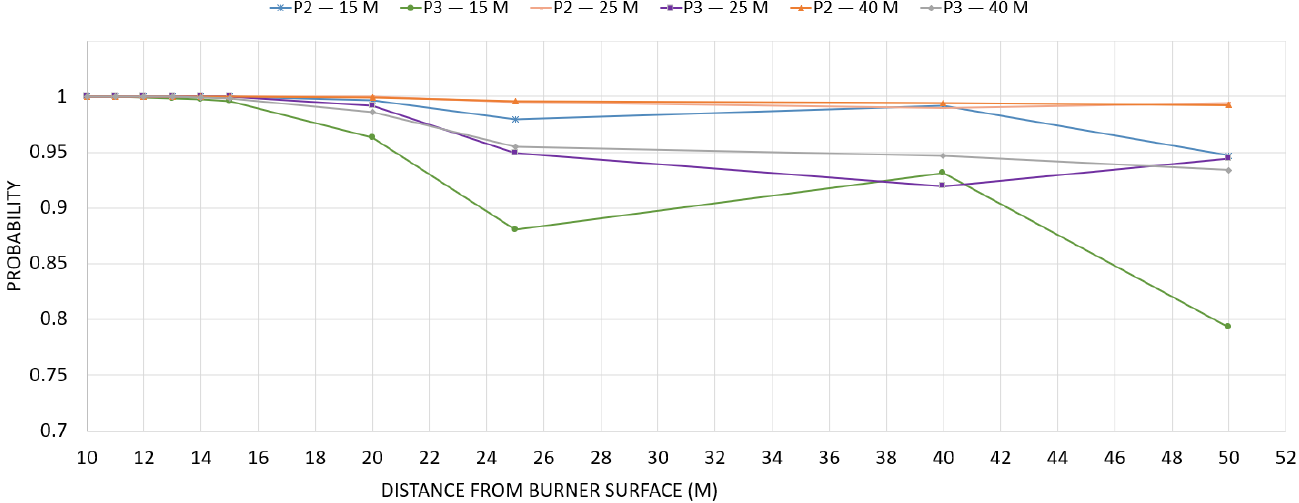
Figure 13. Fire position comparison for probabilistic injury at V L = 2.5 m/s, V T = 0 m/s. P2 and P3 refer to the probability of second and third burn injuries, respectively.